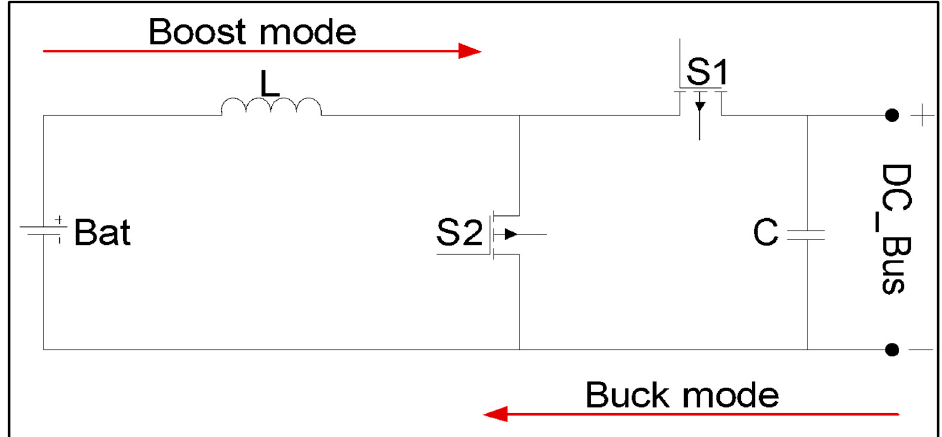
Figure 3. Equivalent bidirectional DC-DC Buck-Boost converter circuit.